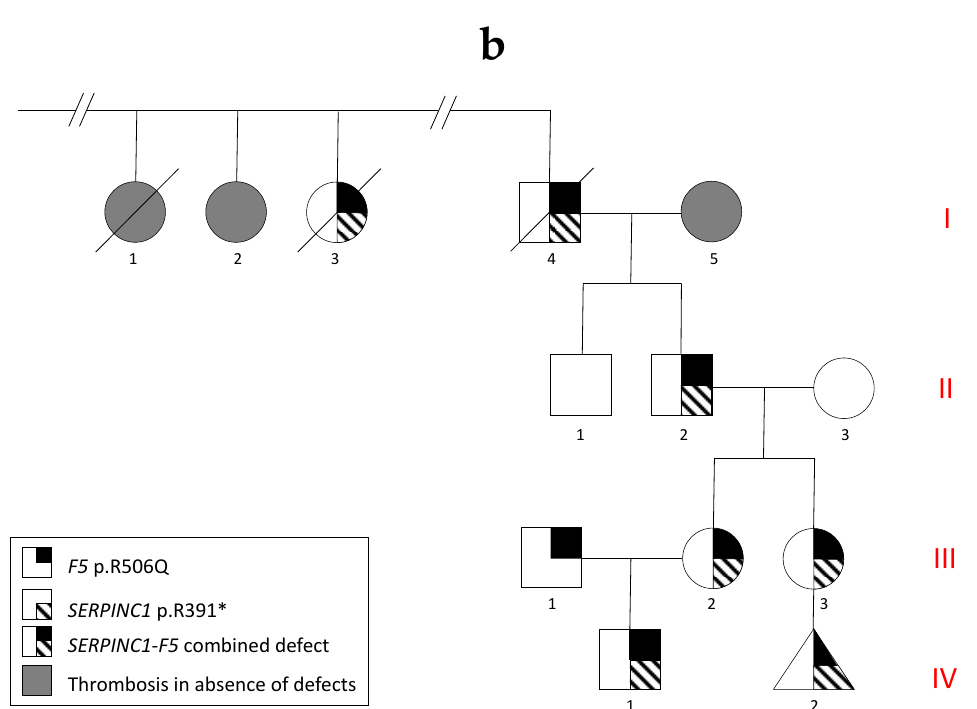
Figure 1. ( a ) Full pedigree of the original family. Black symbols refer to thrombotic subjects carrying the combined AT-FV Leiden defect (i.e., SERPINC1 - F5 mutations). Grey symbols refer to thrombotic subjects in the absence of any identified defect. The asterisk indicates an asymptomatic carrier of a single F5 p.R506Q defect. The triangle symbol indicates aborted fetus. Dashed frame indicates subfamily described in Figure 1b. ( b ). Extended pedigree of the previous investigated family [2]. This is part of the full pedigree shown in Figure 1a (dashed frame). The different symbols are specified in figure legend (bottom left of the figure). The triangle symbol indicates aborted fetus. Strike-through symbols indicate dead individuals.